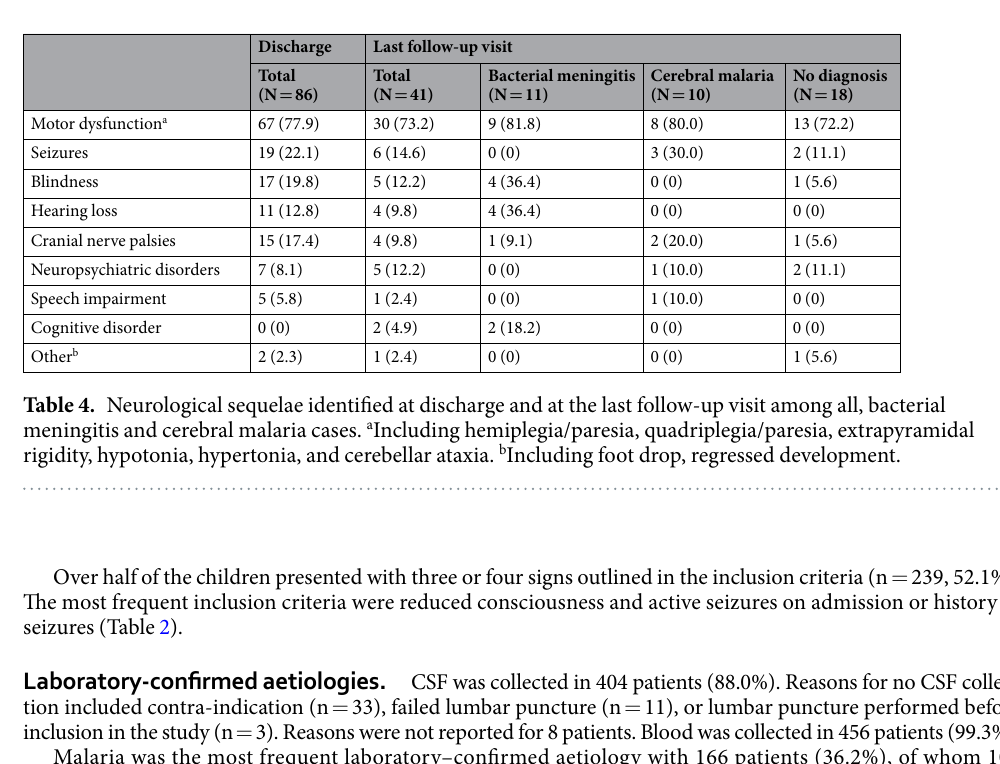
Figure 3. Outcomes at discharge and at the last follow-up visit by etiology. D: outcome at discharge, F: outcome at the last follow up visit.